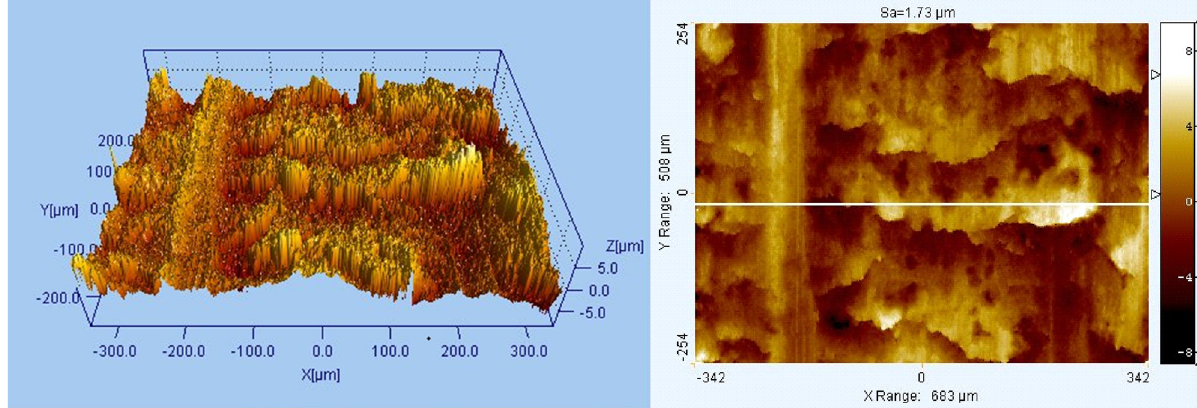
Figure 7: The surface pro fi le image of roughness detection.